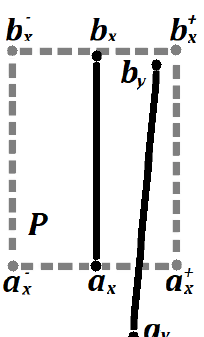
Figure 15. Scheme for determining the segments that belong to the edges of the joint and the parts to be welded (© 2020 IEEE [5]).